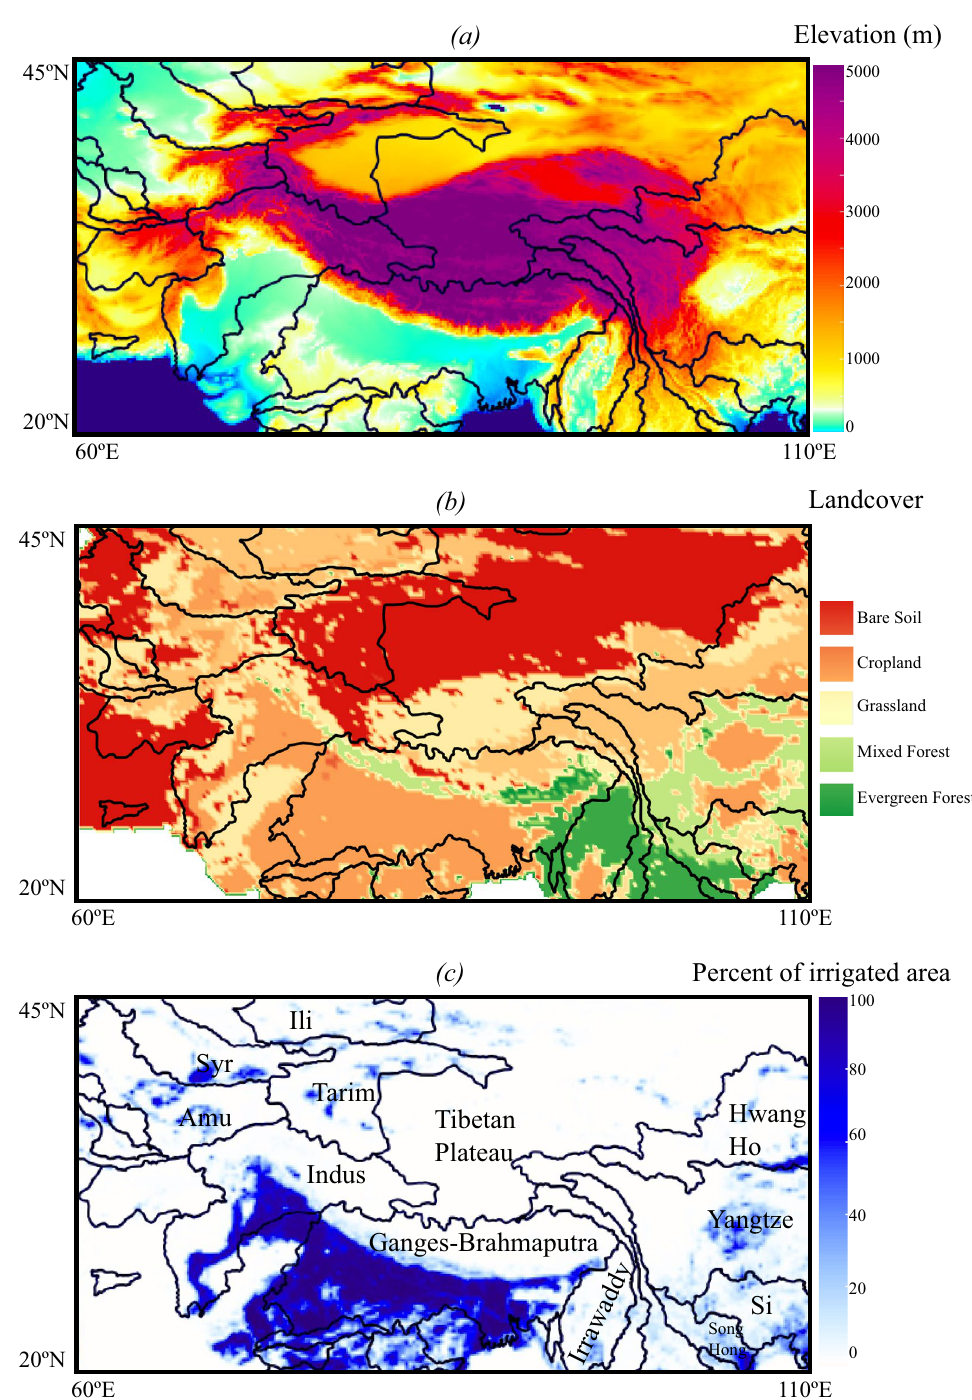
Figure 1. Maps of High Mountain Asia. ( a ) elevation, ( b ) land cover 34 , and ( c ) percent of irrigated areas per pixel 35 . The black lines indicate the limits of the hydrologic basins, and their names are indicated in ( c